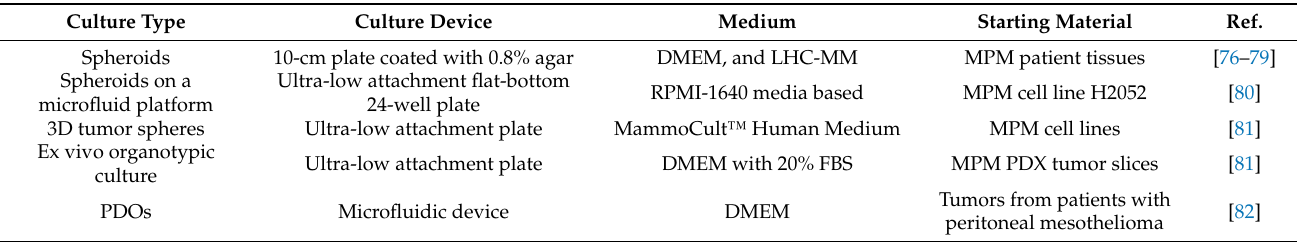
Table 1. Three-dimensional culture of